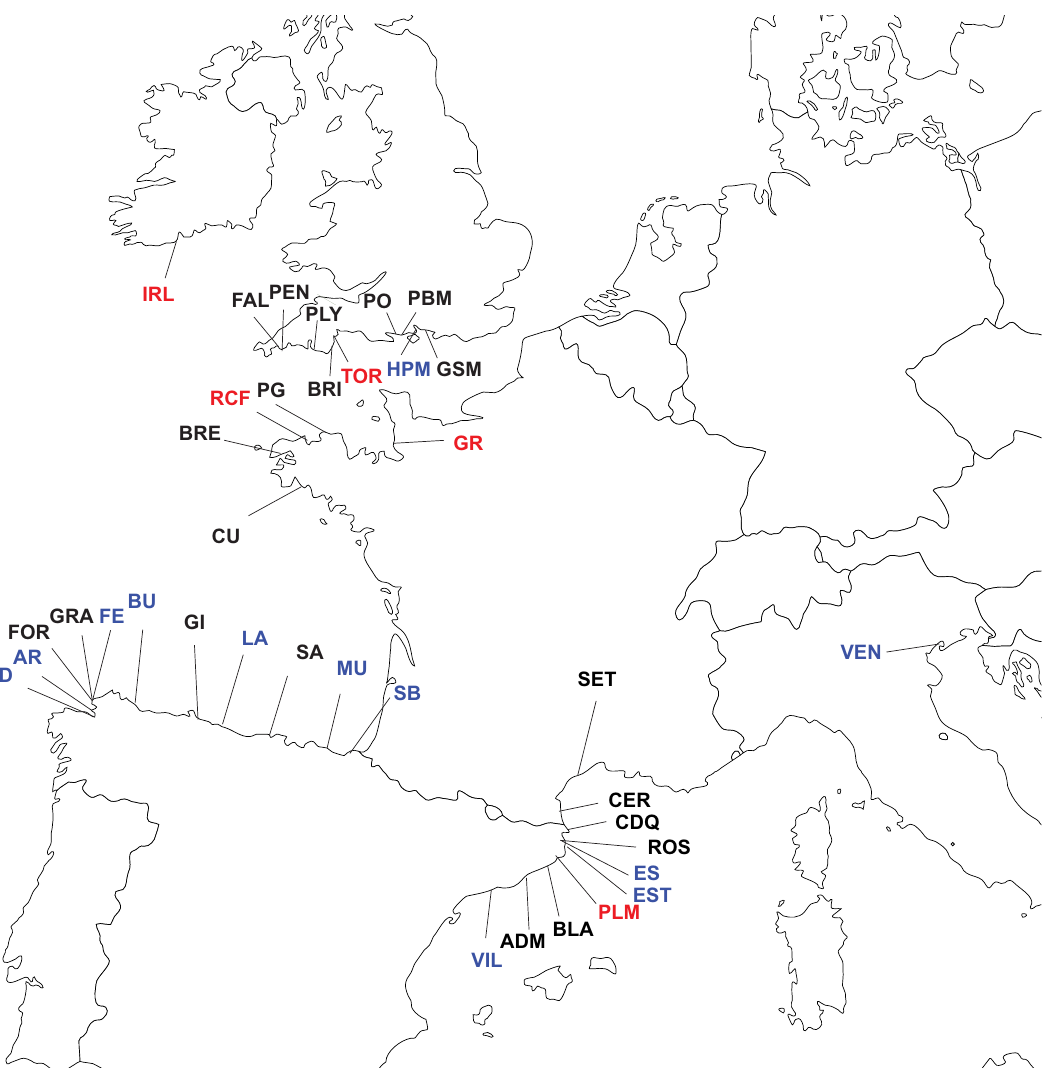
Fig 7. Distribution of Clade A and Clade E throughout the northeastern Atlantic and Mediterranean. Blue Labels = Locationswhere only Clade A was found, Red Labels= Locationswhere only CladeE was found, Black = CladeA and CladeE